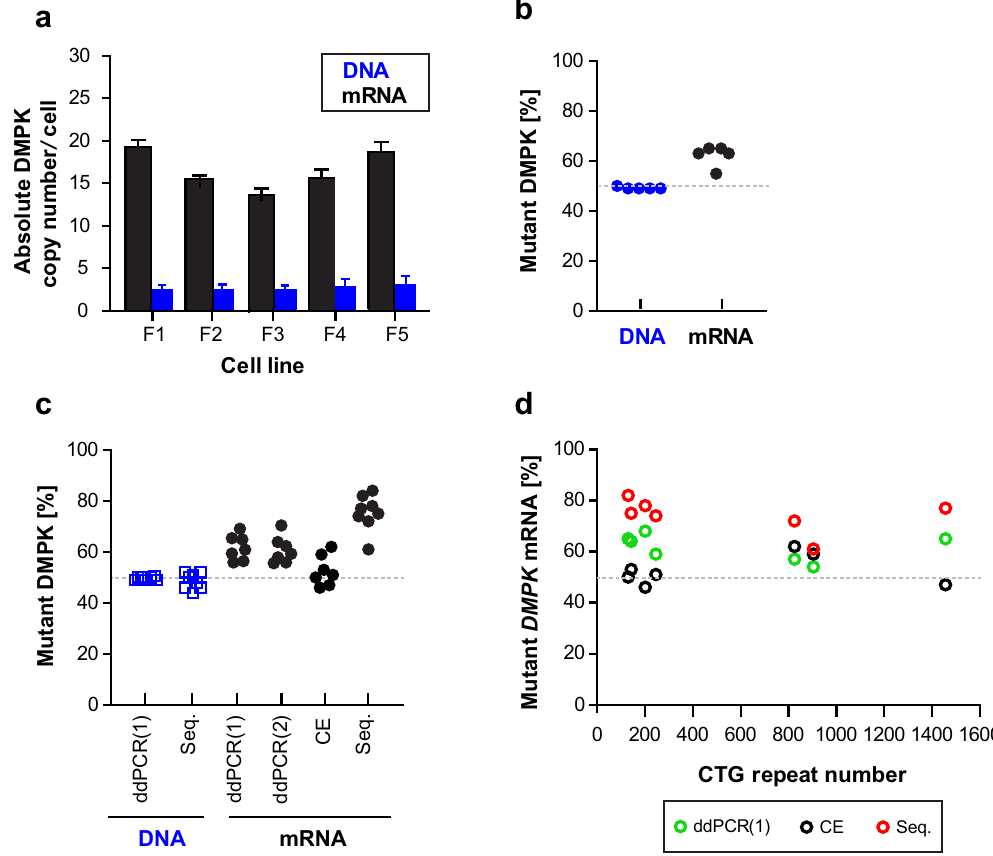
Figure 5. ddPCR-based Quantification of the Absolute DMPK Copy Number per Cell and a Fraction of Mutant DMPK Transcript. ( a ) The absolute DMPK copy number per cell in cDNA (black bars) and gDNA (blue bars) from proliferating human DM1 fibroblasts (lines F1-F5). The cells were semi-confluent at the moment of RNA harvest and their passage numbers were between 20 and 37. All the cell lines were immortalized. Bar graphs represent results from at least three independent culture series per line and data are presented as mean ± SD. ( b ) A fraction of mutant DMPK transcript and allele in DM1 fibroblasts shown in panel (a). The mean values of independent ddPCR measures performed with DMPK probes indicated as variant 1 and 2 are shown. ( c ) A fraction of mutant DMPK transcript and allele in, respectively, human DM1 skeletal muscles and peripheral blood. The fraction was determined with: ddPCR (probe variant 1 and 2), capillary electrophoresis (CE) and Sanger sequencing (Seq.). ( d ) The correlation between a fraction of mutant DMPK RNA (shown in panel c) and CTG repeats number (~130–1500) in DMPK gene is